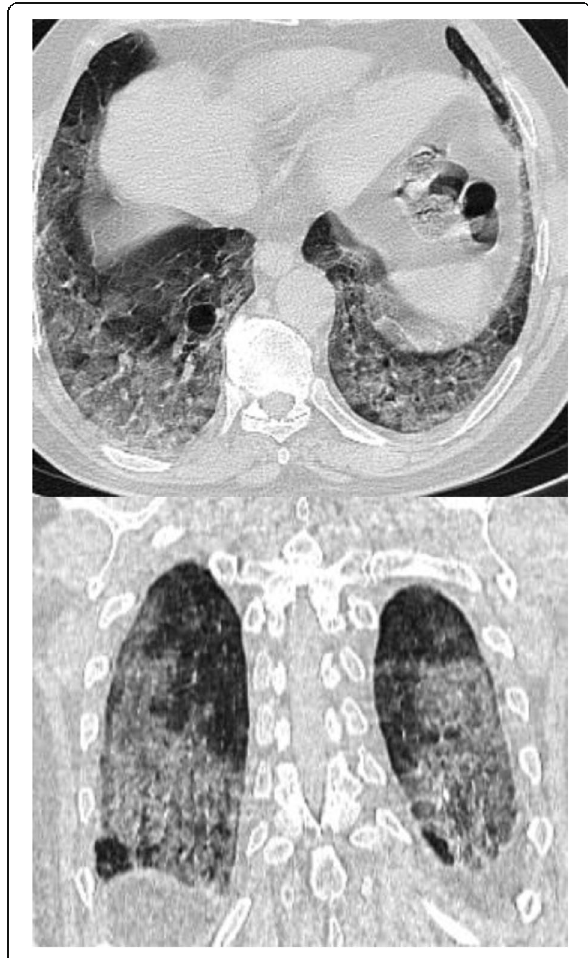
Fig. 9 Axial and coronal CT images of patient with COVID-19, 10 days after the onset of symptoms, showing extensive ground glass infiltration with crazy paving infiltration. The appearance of crazy paving appearance indicates a progressive disease